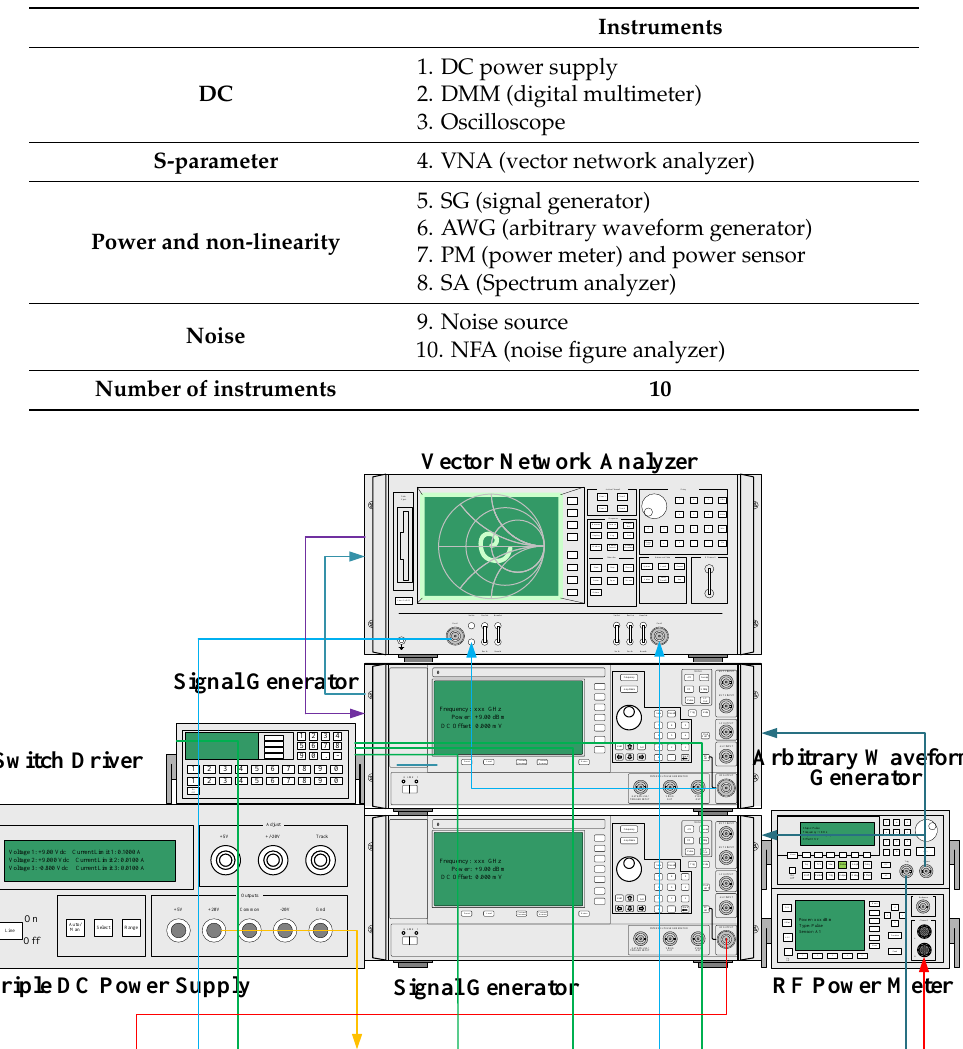
Table 3. Subsystem and their instruments.